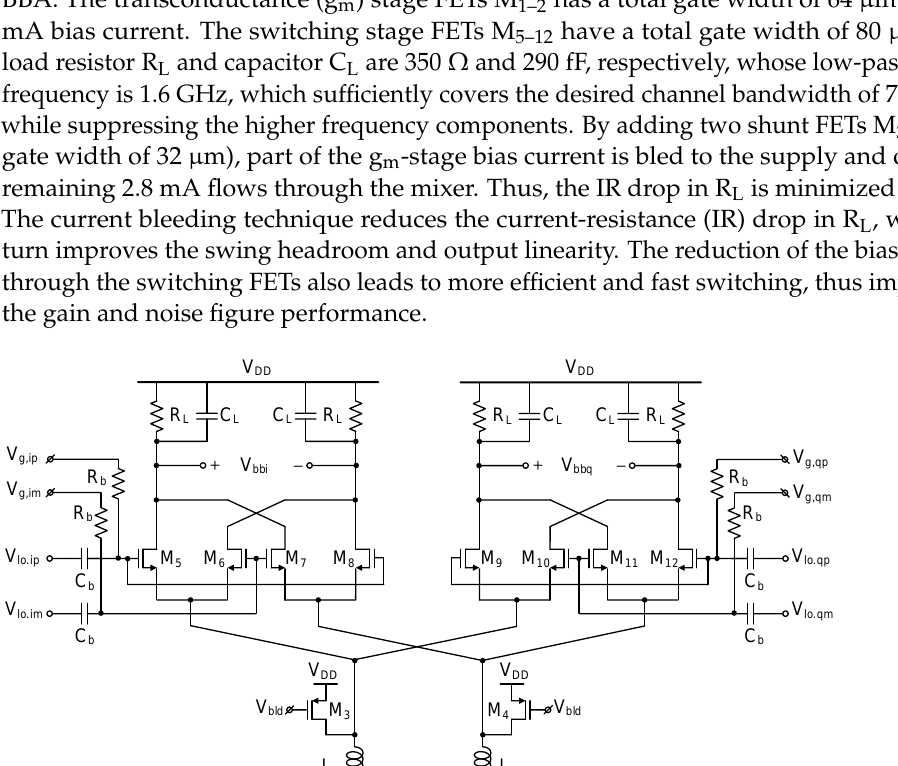
Figure 4. Effects of the interstage inductance L m on the mixer performance. As shown in Figure 3, the differential I/Q LO signals V lo,ip , V lo,im , V lo,qp , V lo,qm are fed to the switching FETs M 5 – 12 via the ac-coupling capacitor C b of 1 pF. Their independent bias voltages V g,ip , V g,im , V g,qp , V g,qm are applied via the ac-blocking resistors R b of 1 kΩ. I n the previous RF up-conversion mixer [2], authors simply demonstrated that adjusting the mixer’s gate bias voltages could effectively tune the I/Q amplitudes. Nonetheless, we have found that the same technique here shows significant different behavior for the RF down- conversion mixer. Comparative simulation investigations are carried out to reveal the differences. Figure 5a is only the single-path circuit out of the original dual-path quadrature down-conversion mixer. It is enough to examine only the single-path circuit because the dual-path circuit cores produce identical responses. For the simulation, we apply the RF input with a frequency of 24 GHz and power of −40 dBm, the LO signal with a frequency of 23.5 GHz and power of 0 dBm. The resulting baseband signal at 500 MHz is probed at